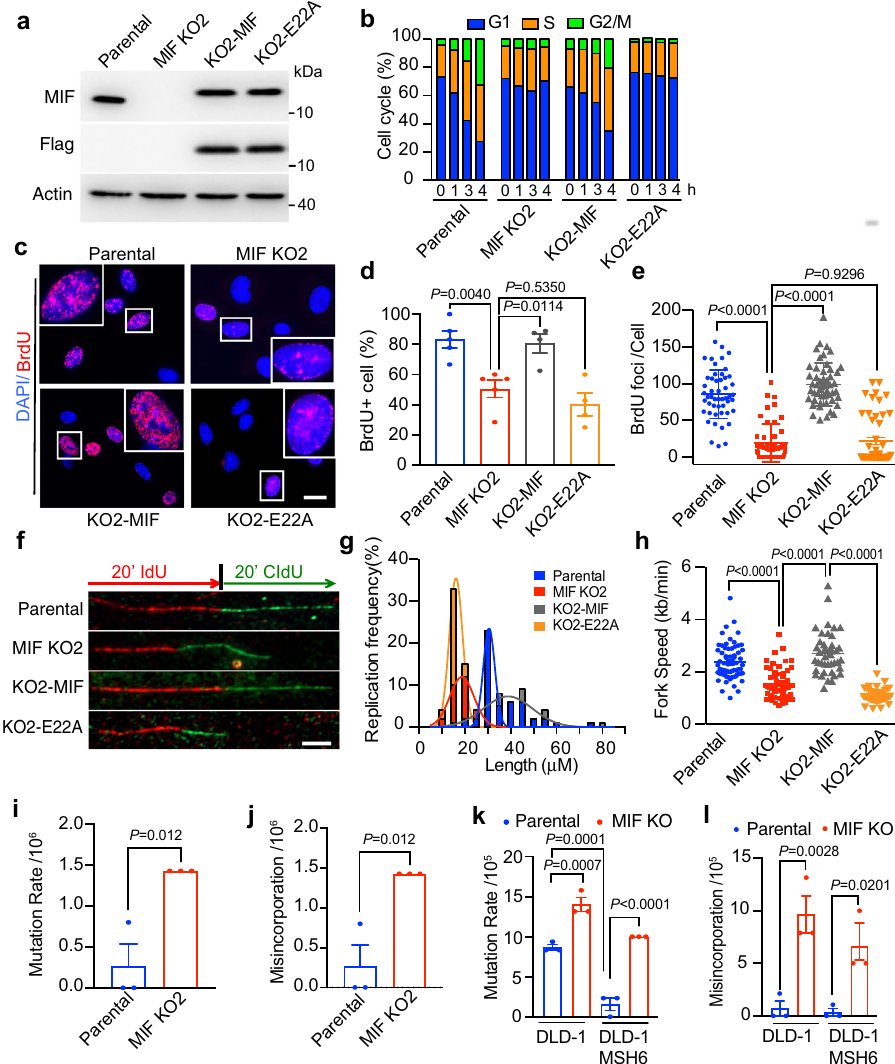
Fig. 3 MIF and its nuclease activity are required for DNA replication and DNA synthesis in cancer cells. a Expression of endogenous MIF and exogenous Flag-tagged WT or E22A MIF proteins in parental and MIF knockout KO MDA-MB-231 cells. b Cell cycle distribution analysis by fl ow cytometry in parental, MIF-KO2, KO2-MIF, and KO2-E22A MDA-MB-231 cells after double thymidine (2 mM) synchronization followed by 1, 3, and 4 h fresh medium incubation. c Representative images of BrdU (red) and DAPI (blue) staining in parental, MIF-KO2, KO2-MIF, and KO2-E22A MDA-MB-231 cells after double thymidine (2 mM) synchronization followed by 2 h fresh medium incubation. Scale bar, 20 μ m. d , e Quanti fi cation of BrdU-positive cells ( d ) and BrdU foci numbers per cell ( e ). n = 50 cells in each group were counted over three biologically independent experiments. Foci numbers >20 were counted as BrdU-positive cells. Statistical signi fi cance was determined by one-way ANOVA Dunnett ’ s multiple comparisons test. f Representative images of stretched DNA fi bers in parental, MIF-KO2, KO2-MIF, and KO2-E22A MDA-MB-231 cells after IdU (25 μ M, 20 min) and CIdU (250 μ M, 20 min) incubation. Scale bar, 10 μ m. g , h Distribution of the track lengths of CIdU and fork progression are indicated in different groups. n = 66 fi bers in the parental group; n = 56 fi bers in MIF-KO2 group; n = 42 fi bers in the KO2-MIF group and n = 54 fi bers in KO2-E22A group were analyzed from three independent experiments. Statistical signi fi cance was determined by one-way ANOVA Dunnett ’ s multiple comparisons test. i , j Mutation frequency analysis including deletion, insertion, and point mutations ( i ) and misincorporation rate analysis ( j ) in MIF-WT and MIF KO MDA-MB-231 cells using HPRT mutation assay (mean ± SEM, n = 3 biologically independent experiments). Statistical signi fi cance was determined by two-tailed Student ’ s t test. k , l Mutation frequency ( k ) and misincorporation rate ( l ) determined by HPRT mutation assay in parental and MIF KO DLD1 and DLD1-MSH6 rescued cells (mean ± SEM, n = 3 biologically independent experiments). Statistical signi fi cance was determined by one-way ANOVA Dunnett ’ s multiple comparisons